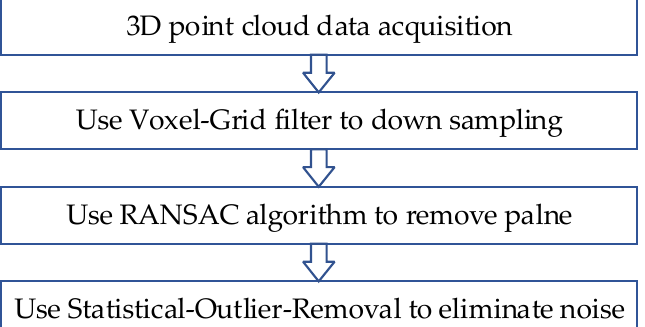
Figure 2. The process of data acquisition and preprocessing.